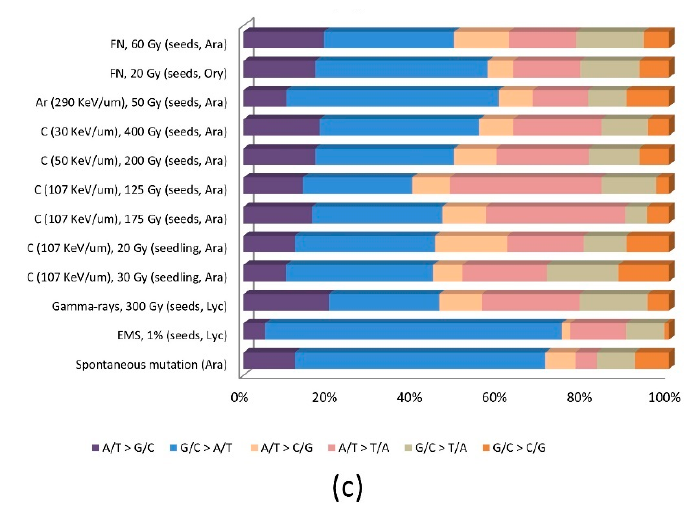
Figure 2. Frequency and spectrum of DNA mutations in mutant lines derived by irradiation. (a) Mutation frequency (× 10 − 7 /bp) estimated for the M 1 generation. (b) Proportion of single base substitutions (SBSs) and InDels. (c) Spectrum of SBSs. The genome information from the studies listed in Table 1 was analyzed. For fast-neutron-irradiated rice, the genome information from Li et al. (2017) [27] was used, but that from Li et al. (2016) [25] was not because the materials in Li et al. (2016) [25] were included in Li et al. (2017) [27]. The results of Du et al (2017) [24] were omitted from (b) because large InDels were not analyzed. Regarding the argon beam irradiation (290 KeV μ m − 1 ), the genome information from Kazama et al. (2017) was used, but that from Hirano et al. (2015) [11] was not because Kazama et al. (2017) [12] analyzed more samples; the irradiation conditions were identical in both studies.